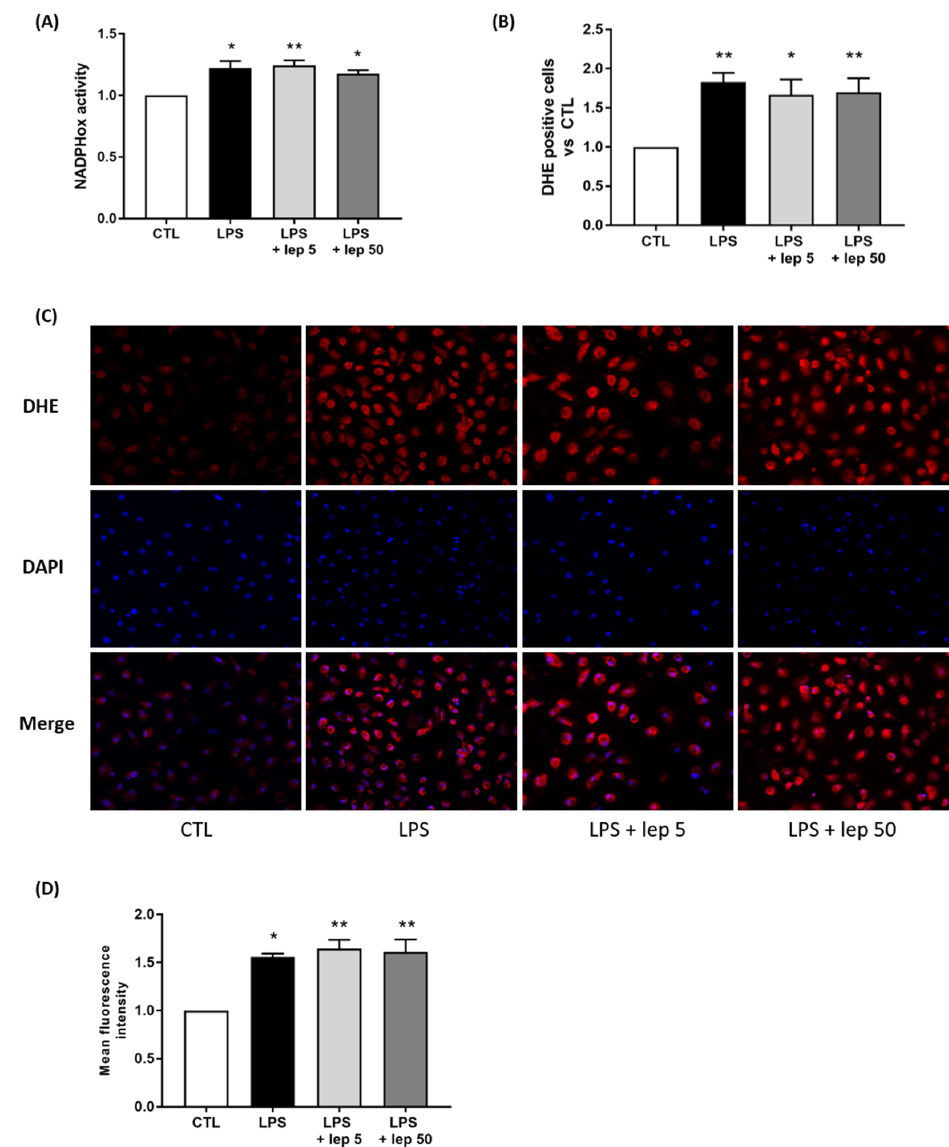
Figure 4. Effect of leptin on ROS production in macrophages. Macrophages were stimulated with LPS and leptin at 5 or 50 ng/mL. ( A ) NADPHox activity measured by luminometric analysis and related to the protein levels. Relative values versus CTL are represented as mean ± SEM, n = 8, * p < 0.05 and ** p < 0.01 versus CTL. ( B ) Proportions of DHE-positive cells represented as fold induction versus CTL (mean ± SEM), n = 5, * p < 0.05 and ** p < 0.01 versus CTL. ( C ) Fluorescence images of DHE (red) and DAPI (blue) staining, taken with an epifluorescence microscope at × 200 magnification in randomly selected fields, representative of five pictures taken for each condition, n = 5. ( D ) Mean fluorescent intensity of DHE staining represented as fold induction versus CTL (mean ± SEM), n = 5, * p < 0.05 and ** p < 0.01 versus CTL.